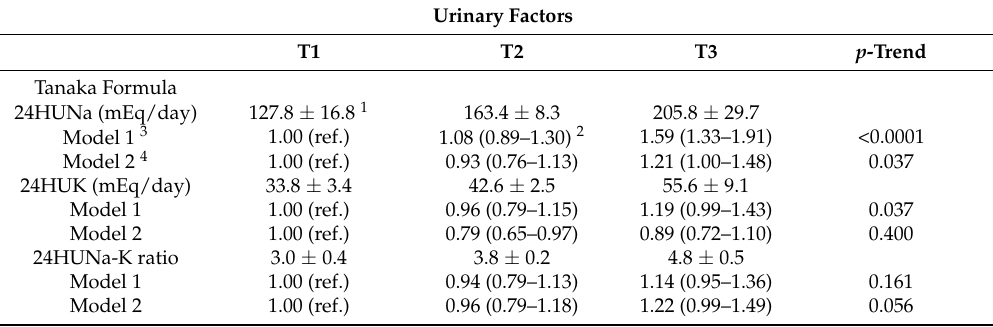
Table 4. Odds ratios (ORs) and 95% confidence intervals (CIs) for hypertension according to 24 h estimated urinary factors obtained with Tanaka and Kawasaki formulas in sample